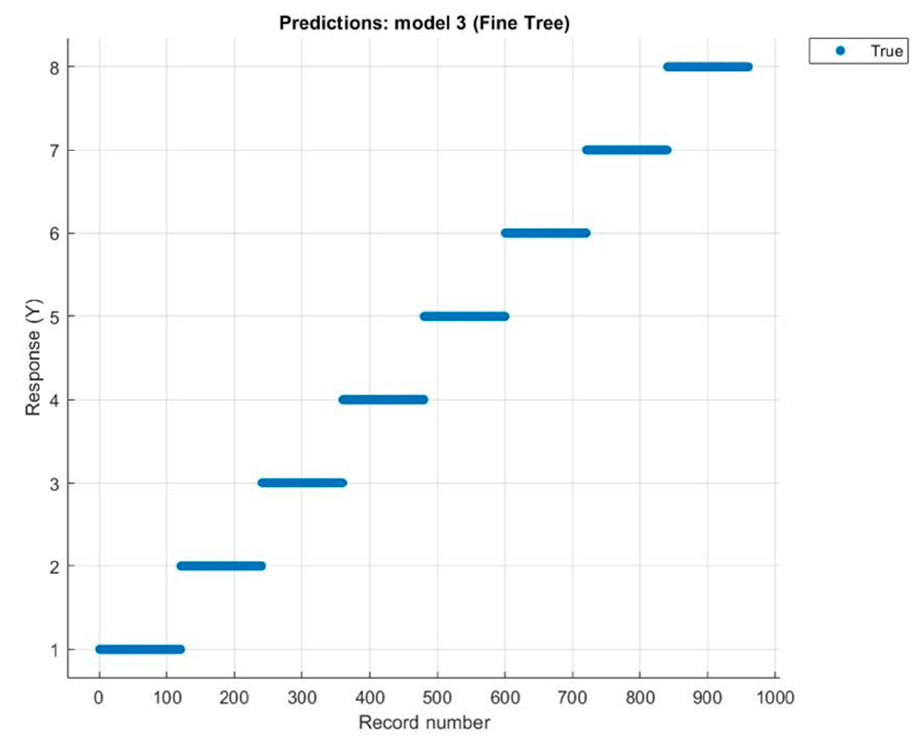
Figure 6. Demonstration of response of the prediction.